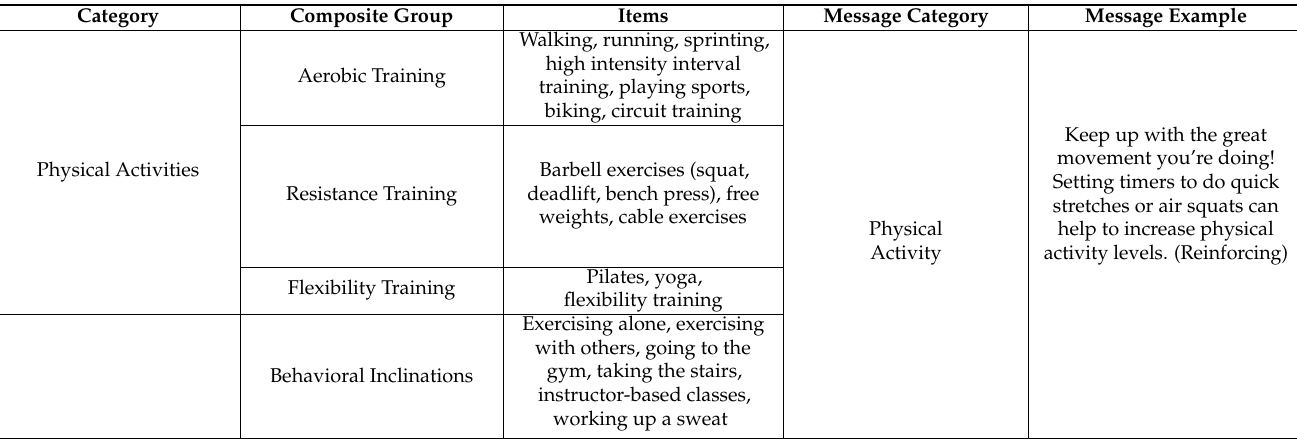
Table 1. Tailored Message Categories and